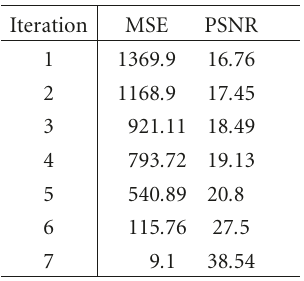
Table 7: Reconstructed image quality using proposed asymmetric turbo code over Rayleigh fading